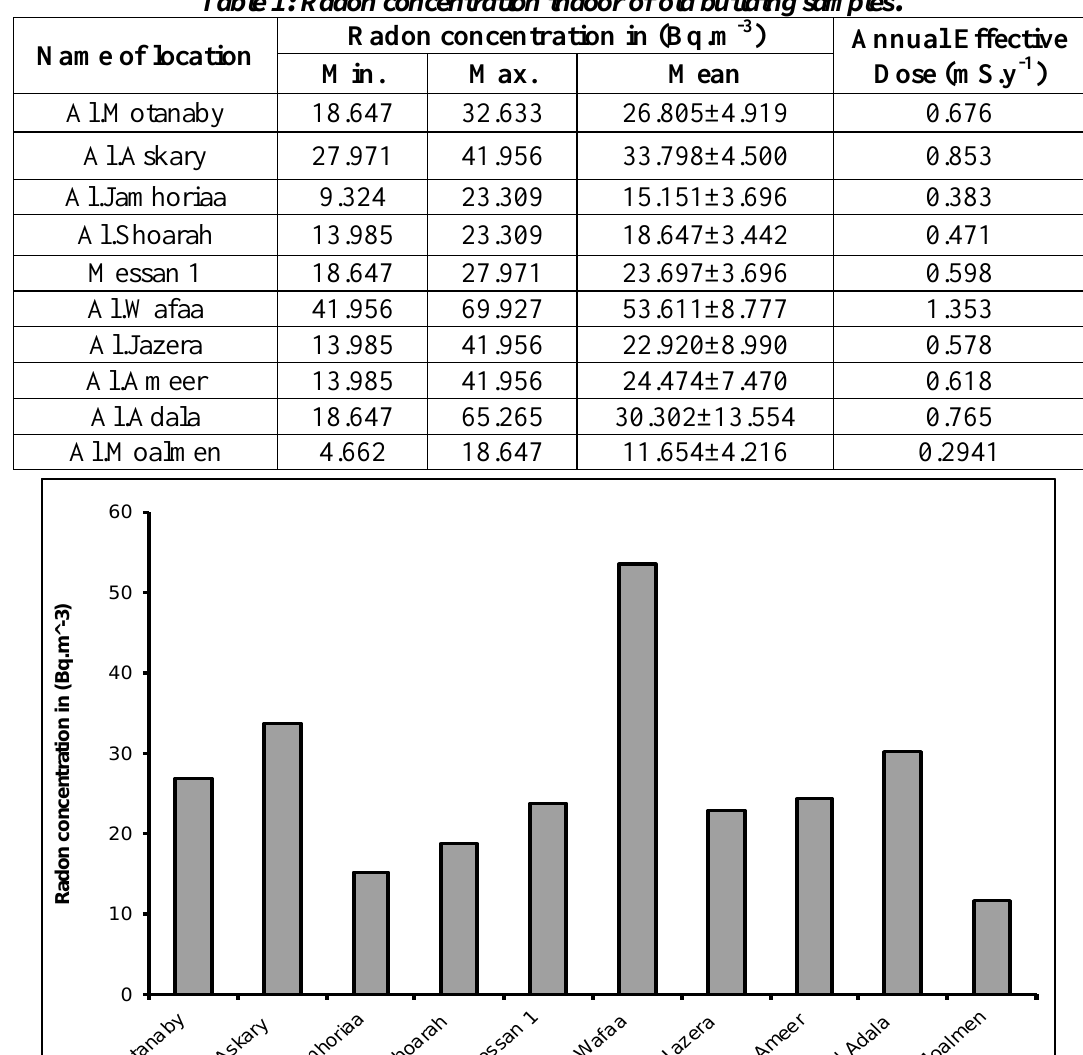
Table 1: Radon concentration indoor of old building samples.